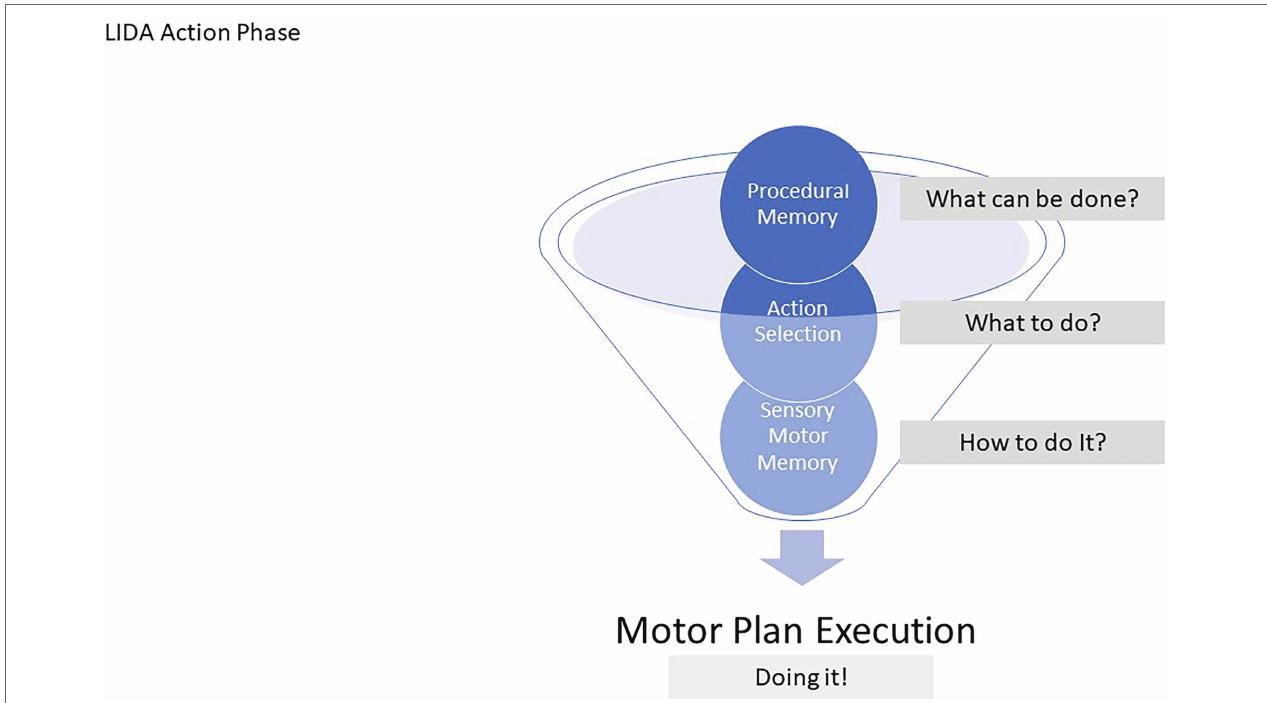
FIGURE 3 | To gain a better grasp of the action selection process in LIDA, it is helpful to think of the process as a funneling toward specificity. Procedural memory contains information about things the agent can do under various circumstances at a somewhat abstract level. Action Selection, broadly speaking, chooses “what to do” in the agent’s particular circumstance. Sensory Motor Memory decides “how to do it” be picking a motor plan, high specificity, and Motor Plan Execution carries out the motor plan. In this way, actions are procedurally selected with increasing